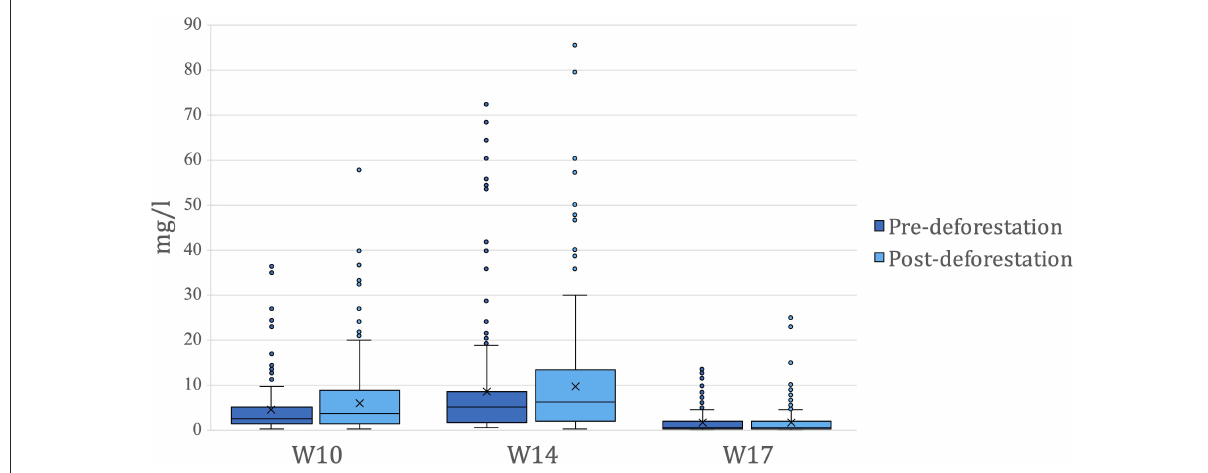
FIGURE5 Boxplots of discharge measured before and after deforestation. Boxplots indicating the distribution prior to the deforestation are colored with darker shades and post-deforestation boxplots are colored with lighter shades. X is indicative of the